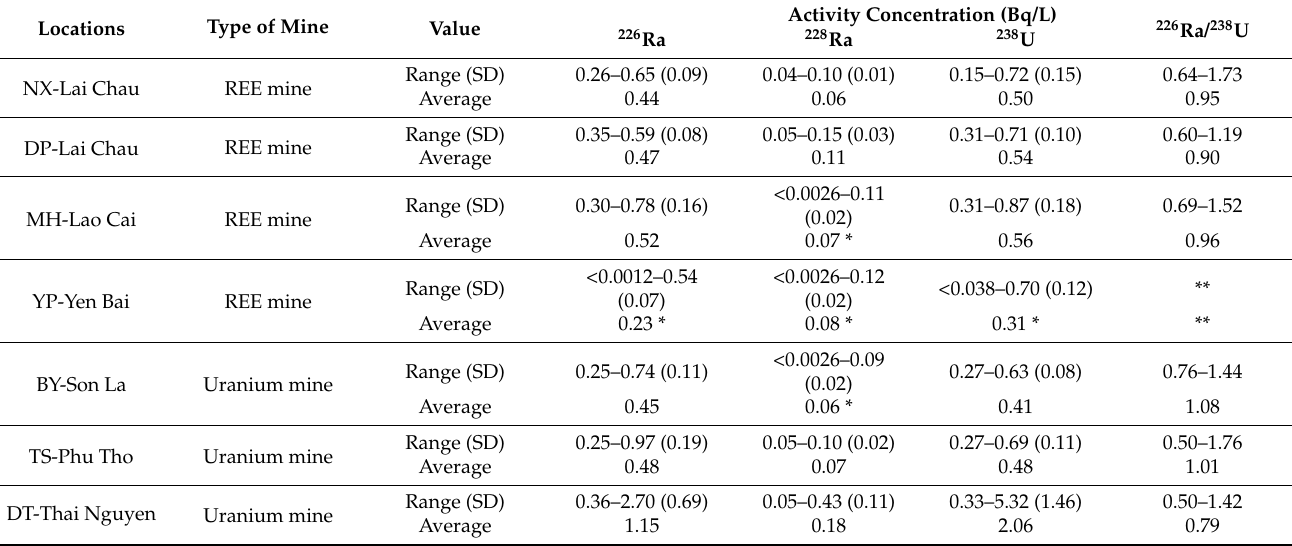
Table 1. Concentration of natural radionuclides in well water samples in North,